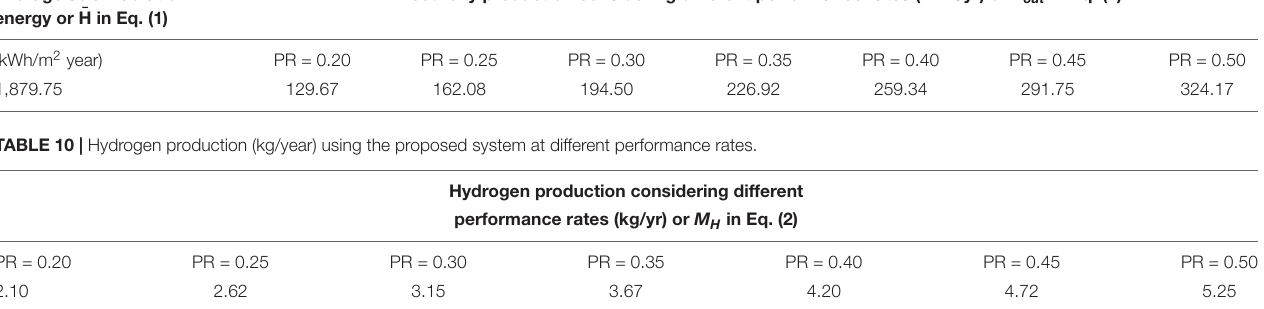
TABLE 9 | Average annual solar radiation energy and output energy of the photovoltaic system. Average solar radiation energy or ¯ H in Eq. (1)